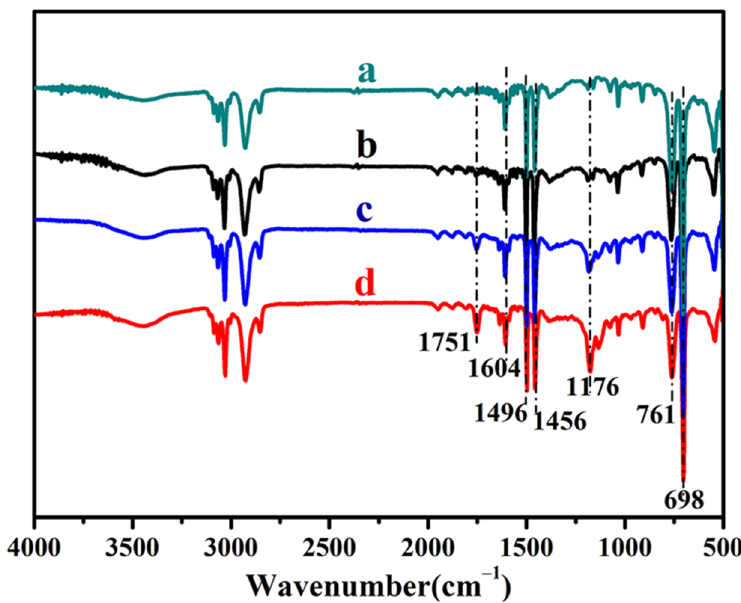
Figure 5. FTIR spectra of (a) PS spheres and the composite particles with different monomer ratios: w OFMA / w St = (b) 1/4, (c) 1/1, (d) 4/1.